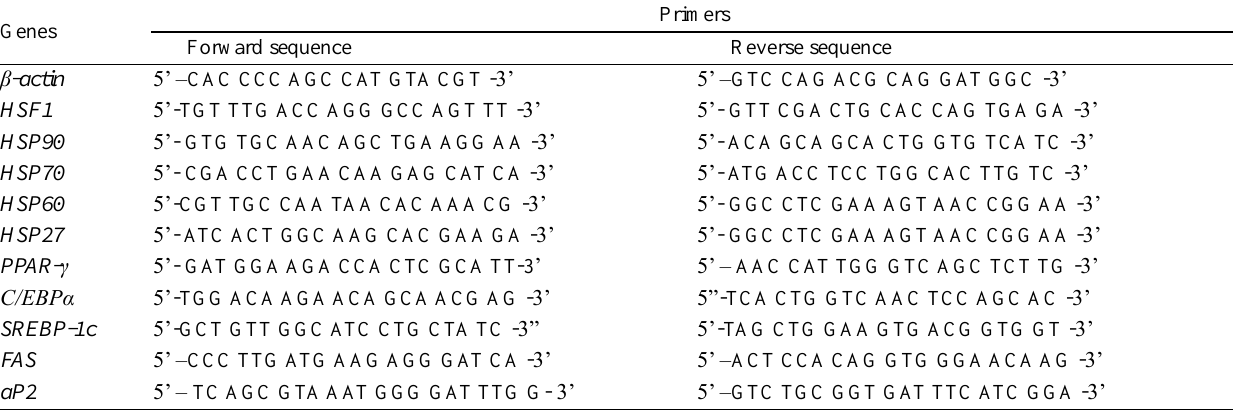
RT-PCR, the real-time polymerase chain reaction; HSF1 , heat shock factor 1; HSP , heat shock protein; PPAR-γ , peroxisome proliferator-activated receptor gamma; C/EBPα , CCAAT/enhancer-binding protein alpha; SREBP-1c , sterol regulatory element-binding protein 1c; FAS , fatty acid synthase; aP2 , adipocyte protein